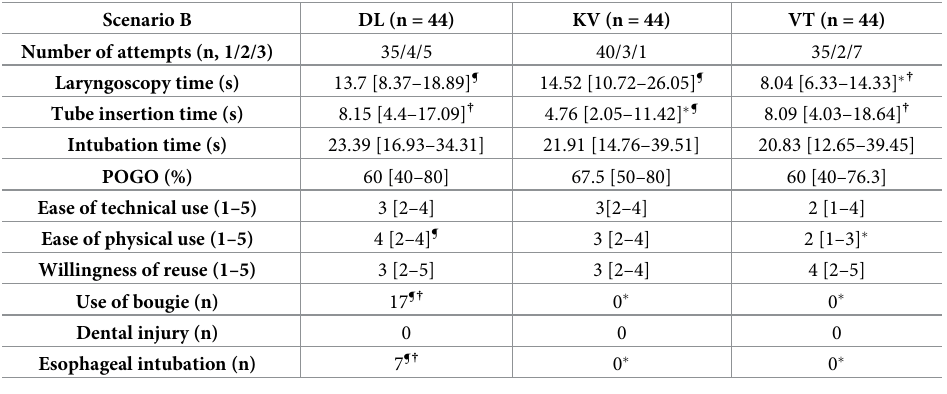
Table 2. Results of “Scenario B”.